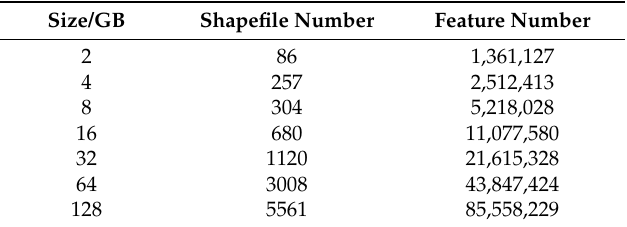
Table 2. The datasets for the parallel conversion test.